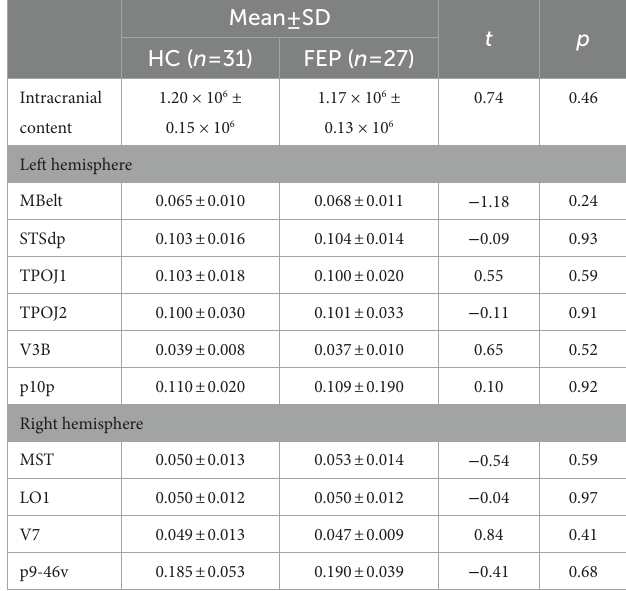
TABLE 5 Gray matter volume.